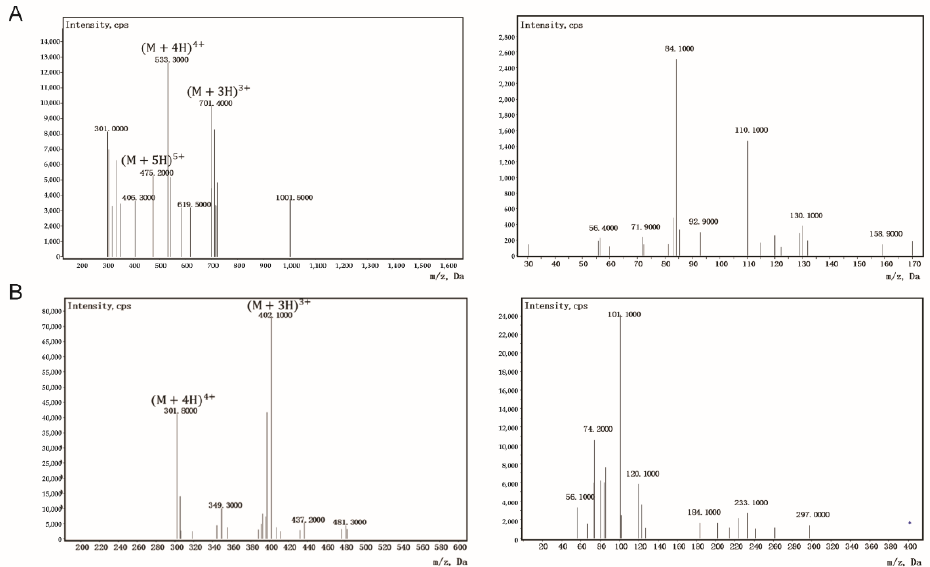
Figure 1. Product ion spectra and fragmentation pattern of AWRK6 ( A ) and internal standard ( B ).